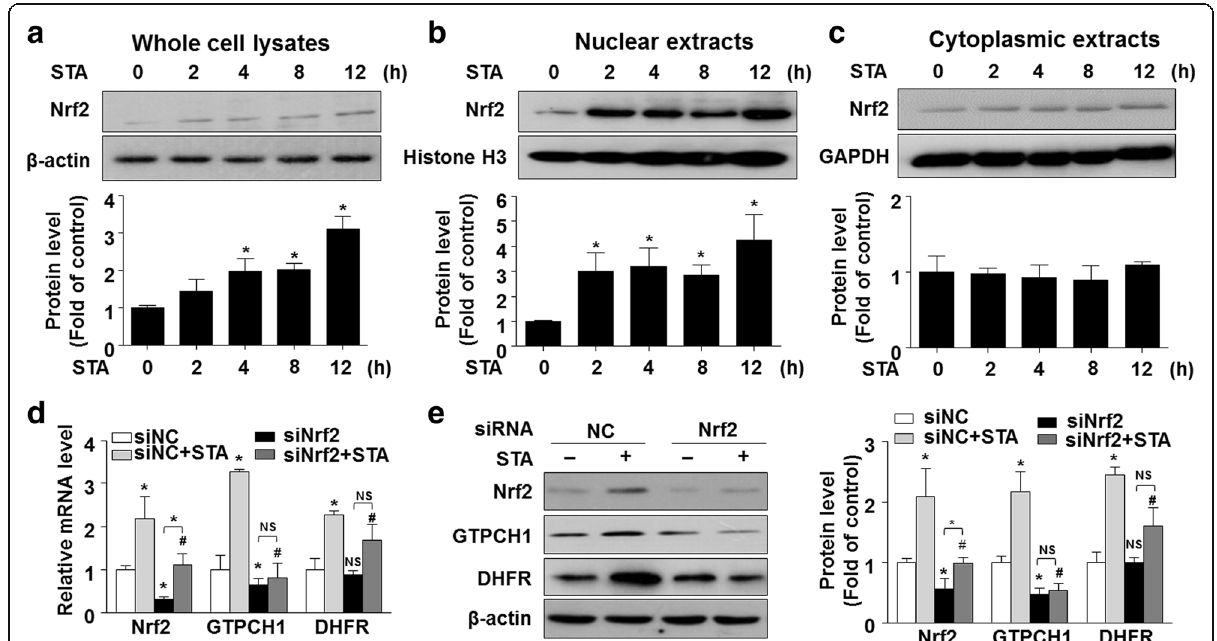
Fig. 6 STA increased the expressions of GTPCH1 and DHFR via Nrf2 activation. Western blotting analysis of Nrf2 protein levels in whole ( a ), nuclear ( b ) and cytoplasmic ( c ) fractions. Quantification of Nrf2 protein levels as in ( a , b and c (bottom)). β -actin, Histone H3 and GAPDH were used for internal controls in whole, nuclear and cytoplasmic fractions, respectively. d ECs were transfected with scrambled siRNA or Nrf2 siRNA for 24 h and then treated with STA (10 μ M) for another 24 h. The mRNA levels of Nrf2, GTPCH1 and DHFR were assessed by using qRT-PCR. e Western blotting analysis of Nrf2, GTPCH1 and DHFR protein levels. Quantification of Nrf2, GTPCH1 and DHFR protein levels as in H (right, n =3). Data shown were mean±SEM. * P <0.05